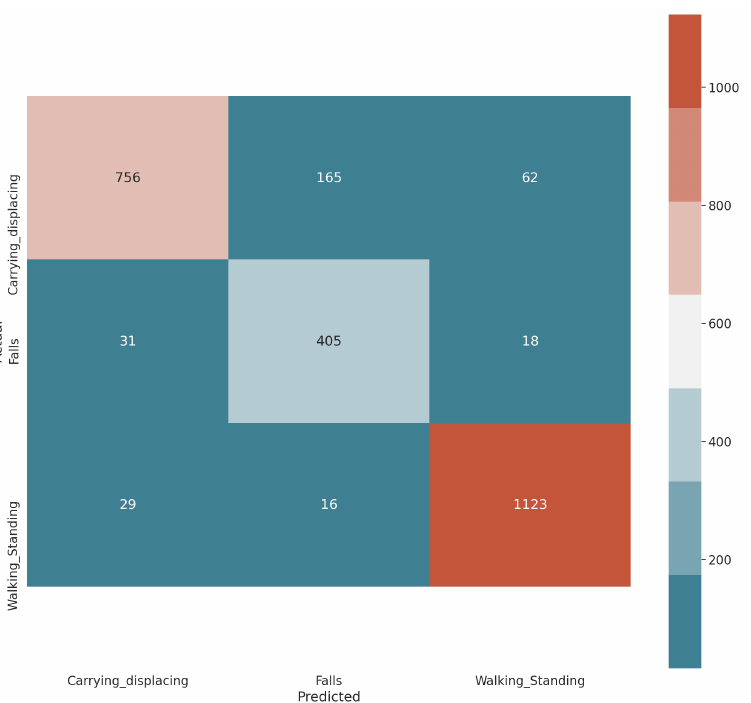
Figure 15. Confusion matrix